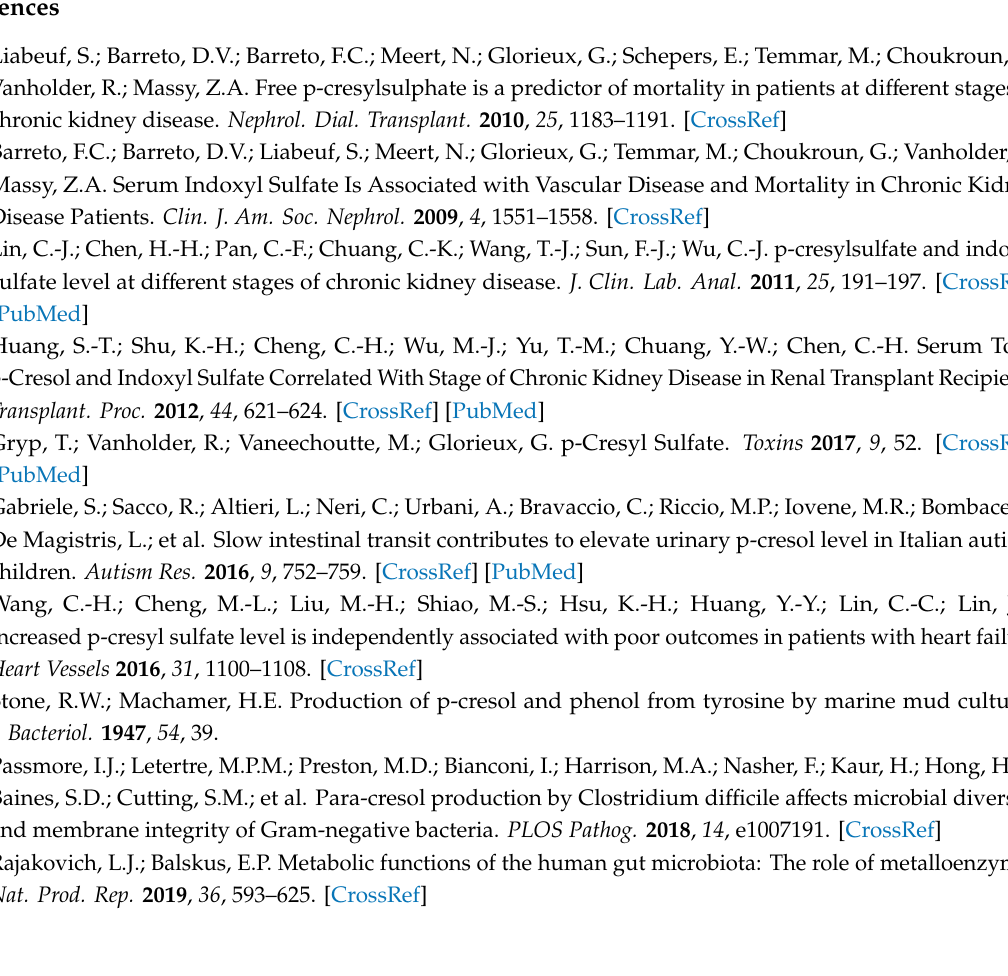
Figure S1. A: negative-ion fragment spectrum of pCS re-elaborated from Attygalle et al., 2001; center-of-mass collision energy 4.88 eV), B: Fragment spectrum of pCS (our measurement, center-of-mass collision energy 4.88 eV). Figure S2. Breakdown curves of the main ion species of pCS (1; A) and 2-hydroxy-4-methyl-phenylsulfonic acid (2; B). Figure S3. Possible mechanisms for the formation of the observed fragment ions in the spectra of: A) pCS (1) and B) 2-hydroxy-4-methyl-phenylsulfonic acid (2). Three further articles are cited as accompanying